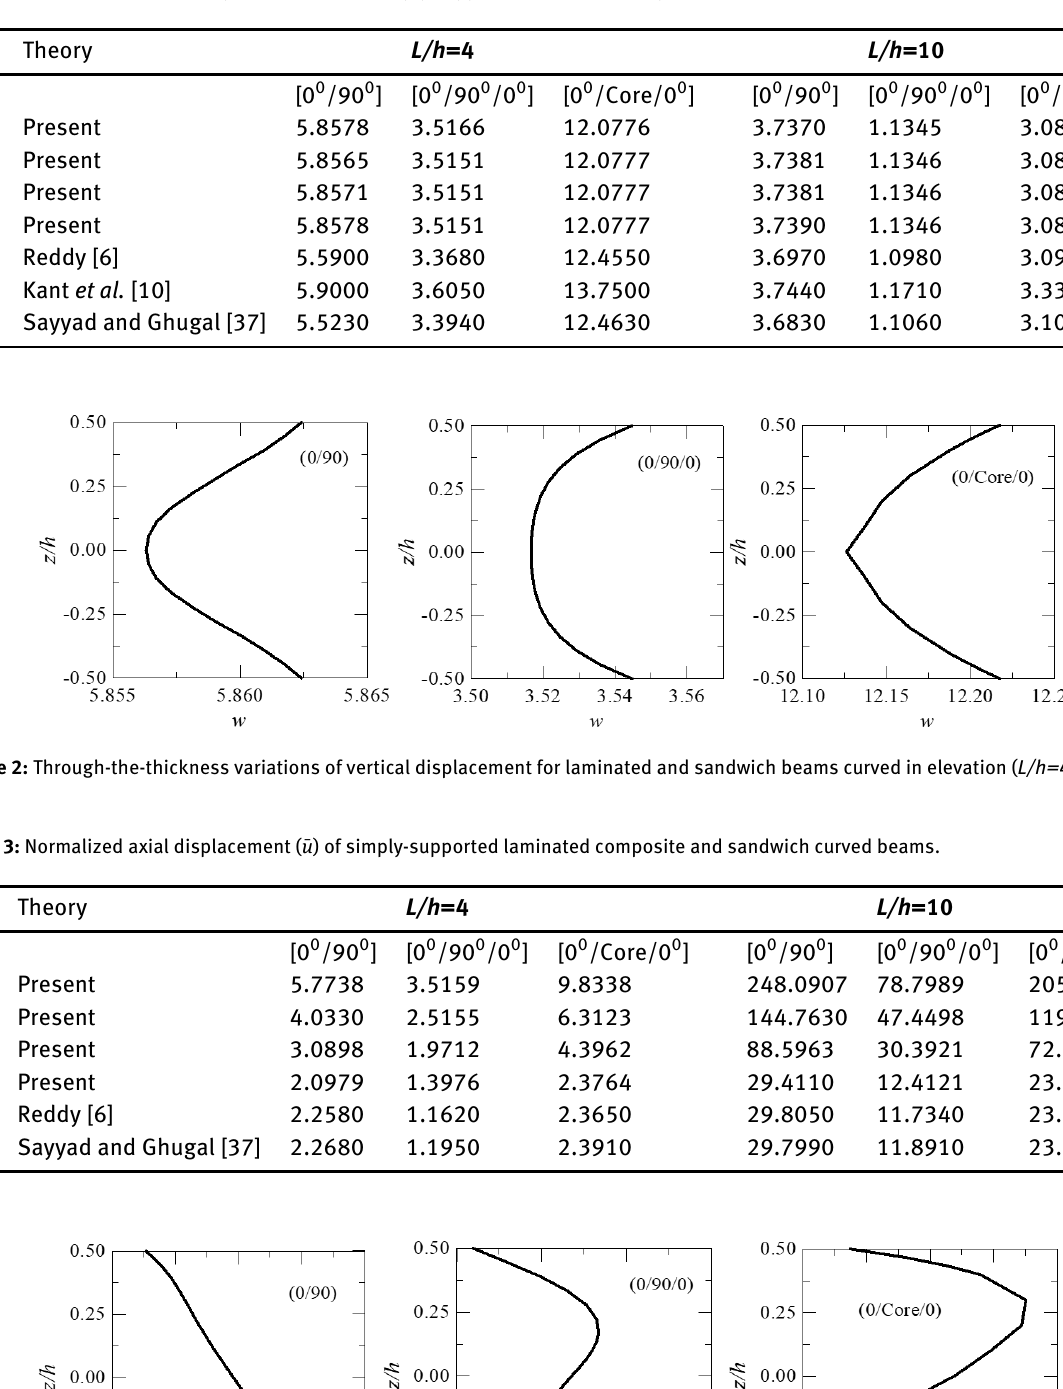
Table 2: Normalized vertical displacement ( ¯ w ) of simply-supported laminated composite and sandwich curved beams.